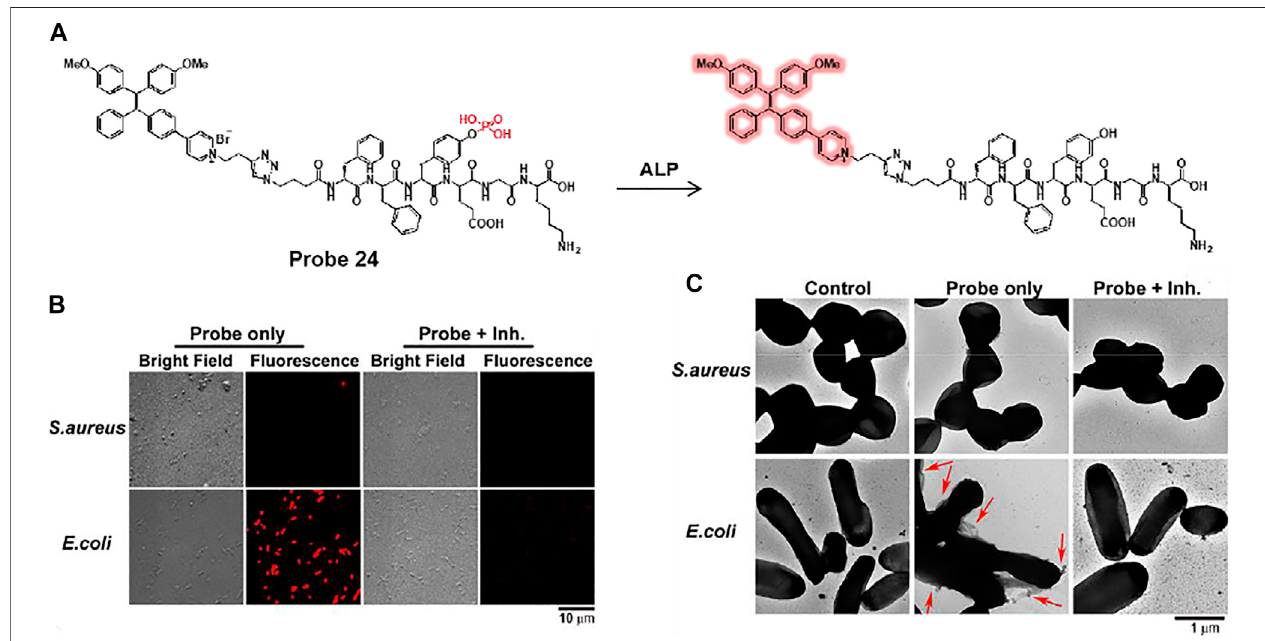
FIGURE 12 | (A) Dephosphorylation reaction of probe 24 by ALP. (B) Confocal microscopy and (C) TEM images of S. aureus and E. coli after incubation of probe 24 with or without L-phenylalanine, an ALP inhibitor. Red arrows indicate the fi brous structure on the surface of E. coli . Reproduced with permission from Zhang et al.